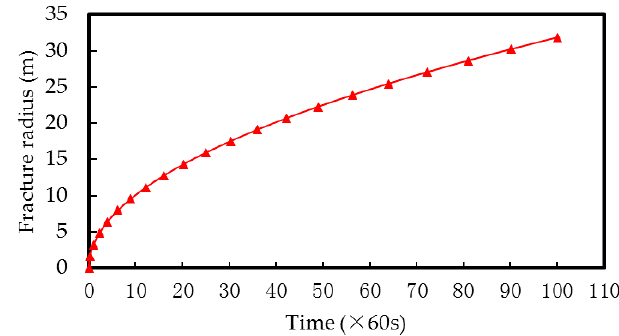
Figure 4. Relationship between horizontal fracture radius and time.